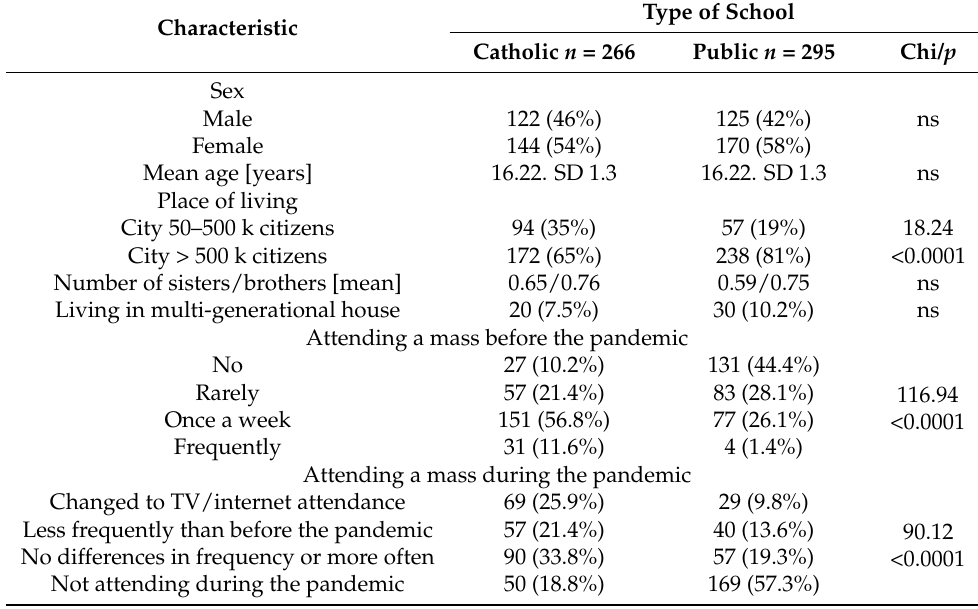
Table 1. Detailed information on the participants taking into consideration the type of school (Catholic versus